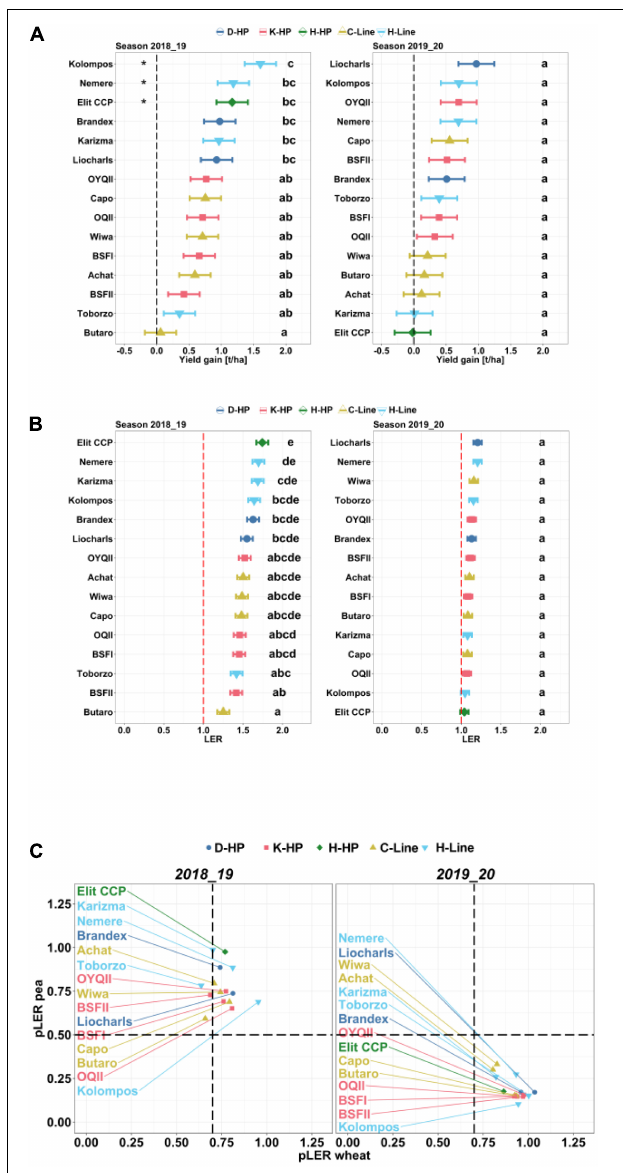
FIGURE 7 | (A) Estimated marginal means and standard error for yield gains, (B) land equivalent ratios (LER), and (C) partial LER of wheat and peas of the 2018/19 and 2019/20 seasons. Significant differences at P < 0.05 estimated from mixed models with pairwise comparison and Holm correction are shown. Letters indicate significant differences between wheat entries. Stars indicate significant differences in yield gain from zero. The vertical dashed line in C represents the sowing ratio of wheat (mix/mono) and the horizontal line the sowing ratio of pea